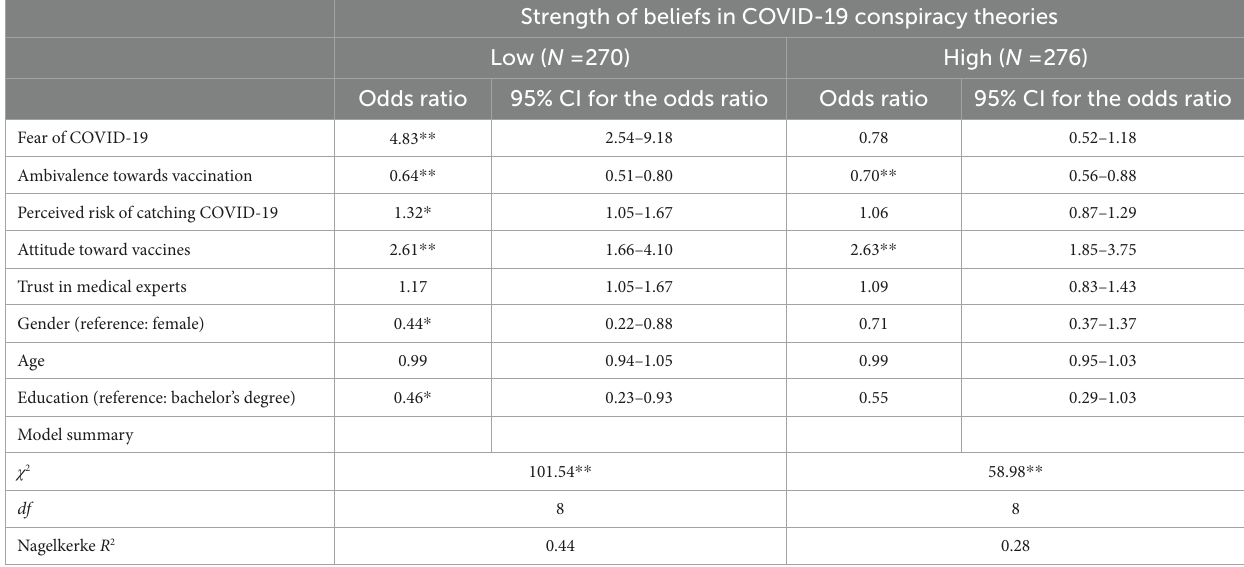
TABLE 4 Summary of logistic regression analysis for variables predicting intention to take the COVID-19 vaccine in the two groups defined by strength of beliefs in COVID-19 conspiracy